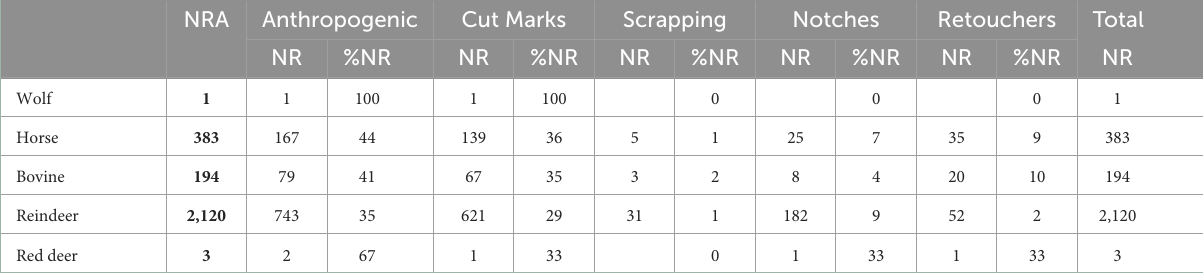
TABLE 5 Anthropogenic modifications par taxa and their